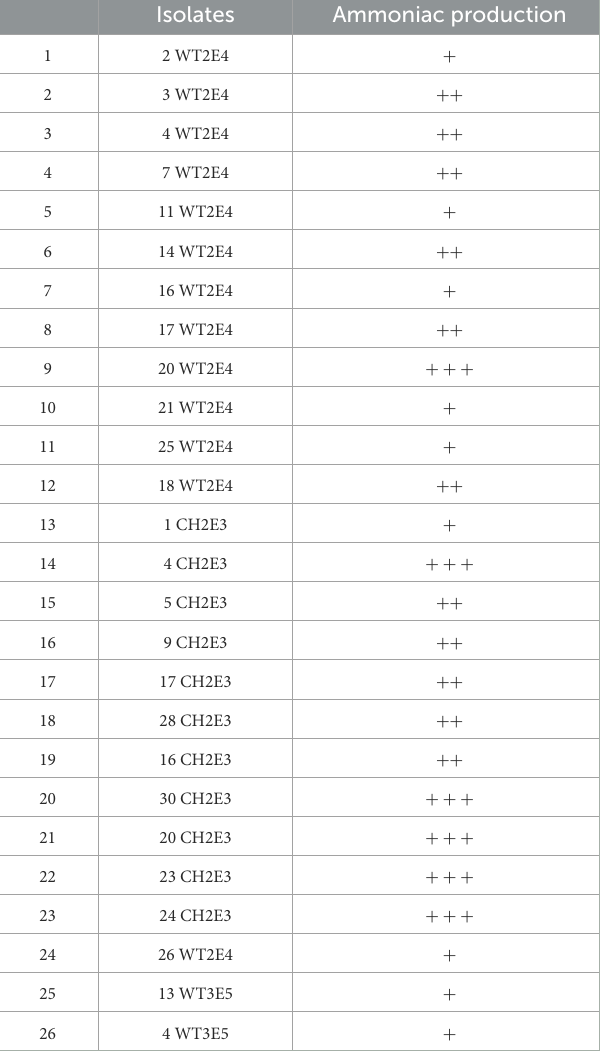
TABLE 2 Ammoniac production activity corresponding to different tested